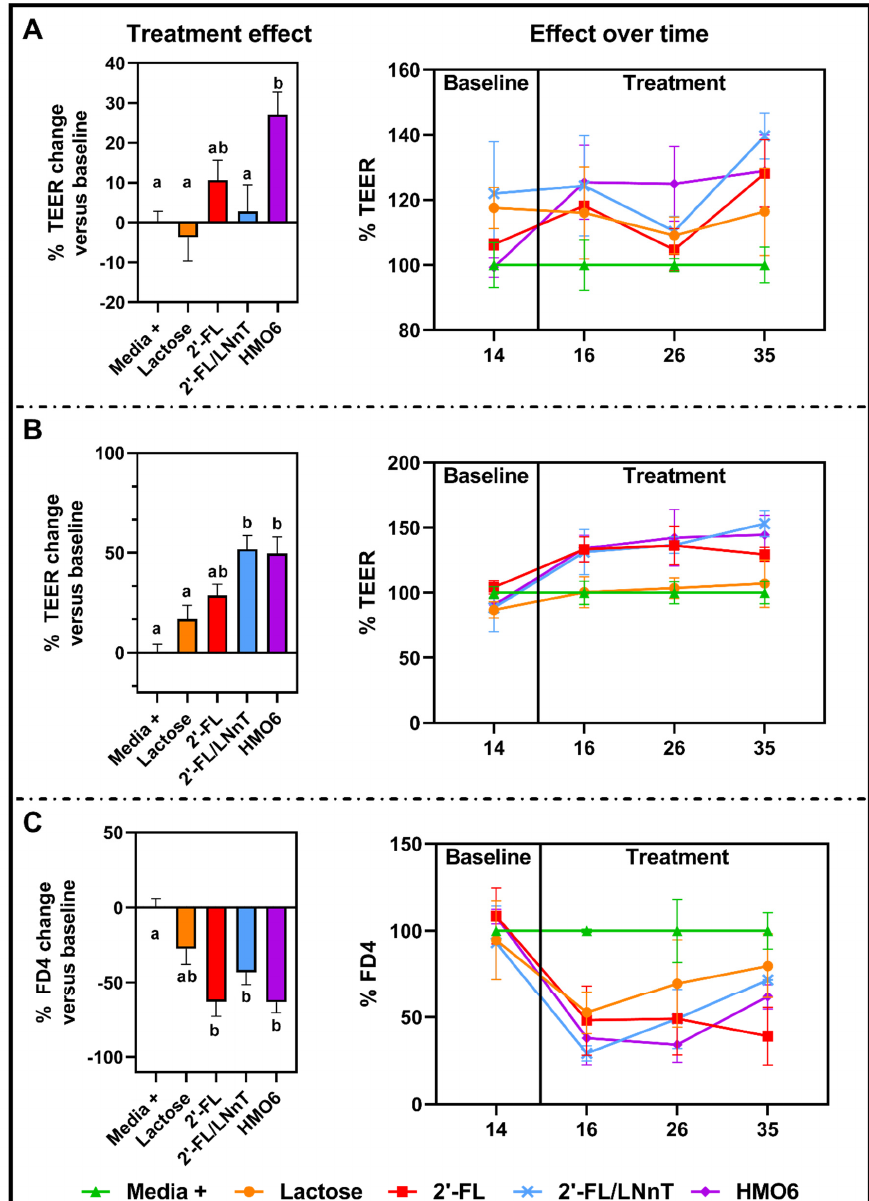
Figure 6. Effect of lactose, 2 ′ -FL, 2 ′ -FL/LNnT, and HMO6 fermentation products on intestinal barrier function in vitro. Percentage of TEER values with respect to baseline (day 14) supernatant values in intact ( A ) or IFN γ /TNF α -challenged ( B ) Caco-2/HT29-MTX monolayers exposed to baby M-SHIME ® supernatants (36 h) from 2 (day 16), 12 (day 26), and 21 (day 35) days of treatment. ( C ) Percentage of FD4 transport to the basolateral compartment with respect to the baseline (day 14) supernatant values in IFN γ /TNF α -challenged Caco-2/HT29-MTX monolayers exposed to baby M-SHIME ® supernatants (36 h) from 2 (day 16), 12 (day 26), and 21 (day 35) days of treatment. Bar plots in the left panel represent the mean ± standard error of the mean (SEM) values at different time points (n = 9) of each treatment. Time-course graphs in the right panel represent measures (mean ± SEM, n = 3) at different time points, and data are expressed relative to Media+ (100%) at each time point. Significant differences between treatments (one-way ANOVA with Bonferroni correction) are indicated with different letters (a, b; p < 0.05). Treatments sharing at least one letter are not significantly